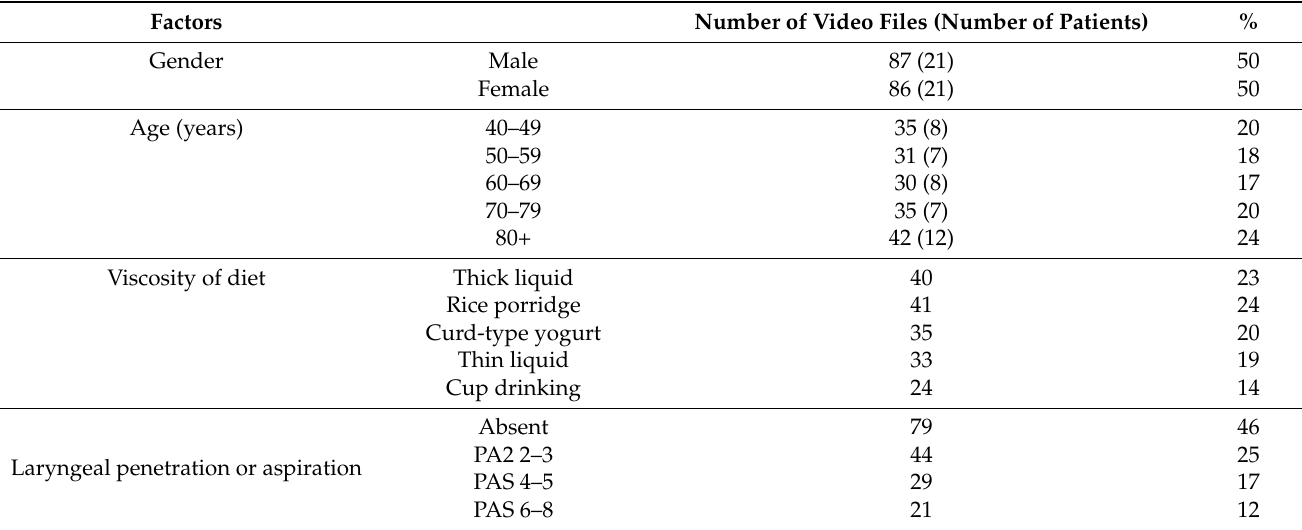
Table 1. Characteristics of VFSS dataset for test.